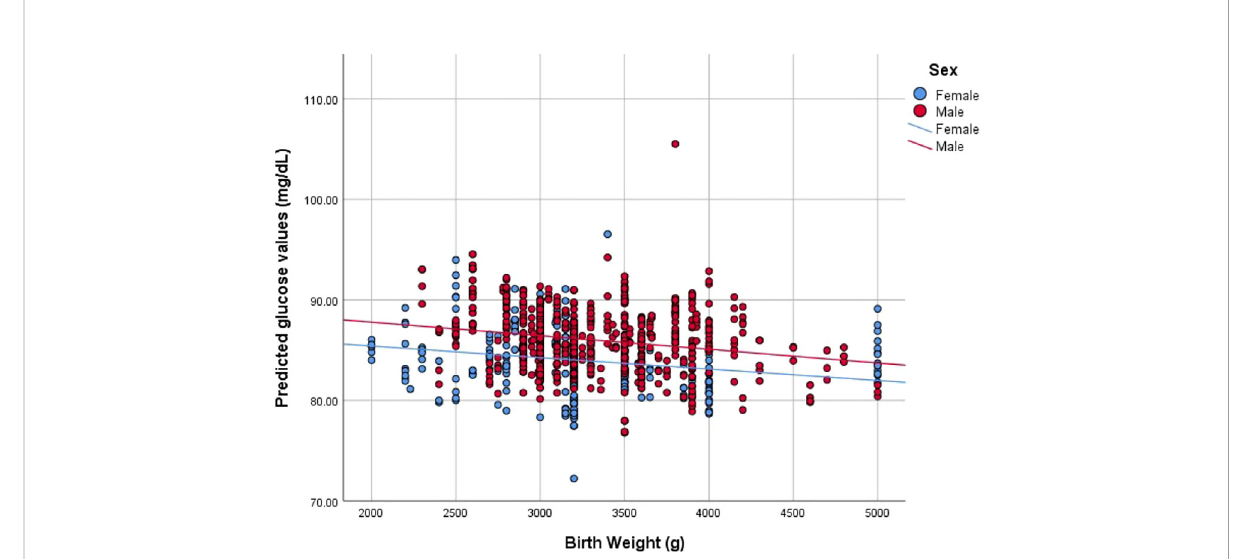
FIGURE 1 Correlation between Birth weight (g) and predicted glucose values (mg/dL) strati fi ed by